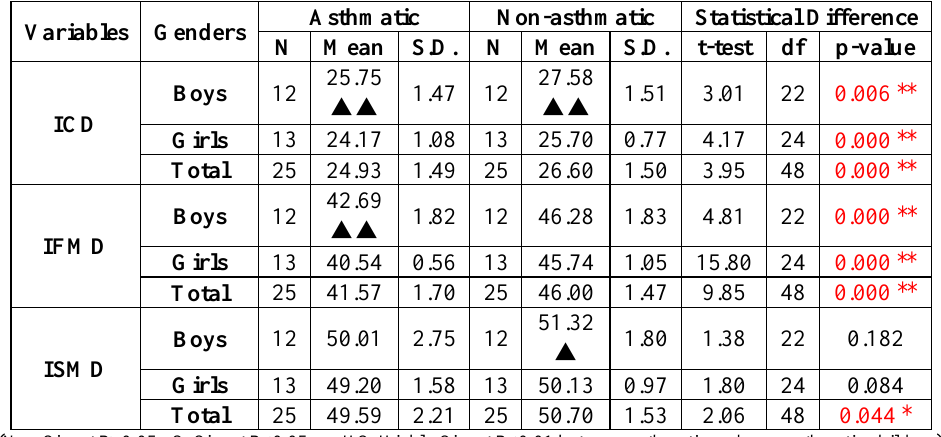
Table 2: Mandibular arch width (mm) among asthmatic and non-asthmatic children by genders Asthmatic Non-asthmatic Variables Genders